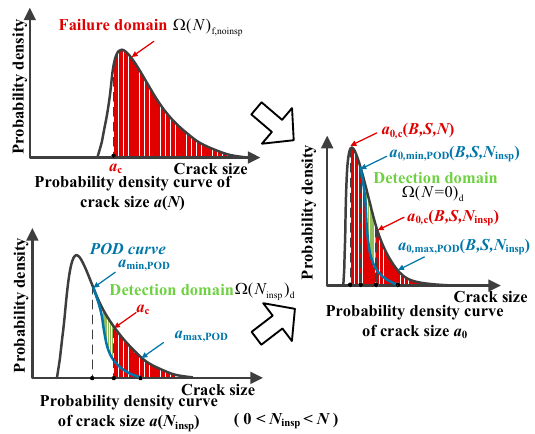
Figure 6. Detection domain through POD.